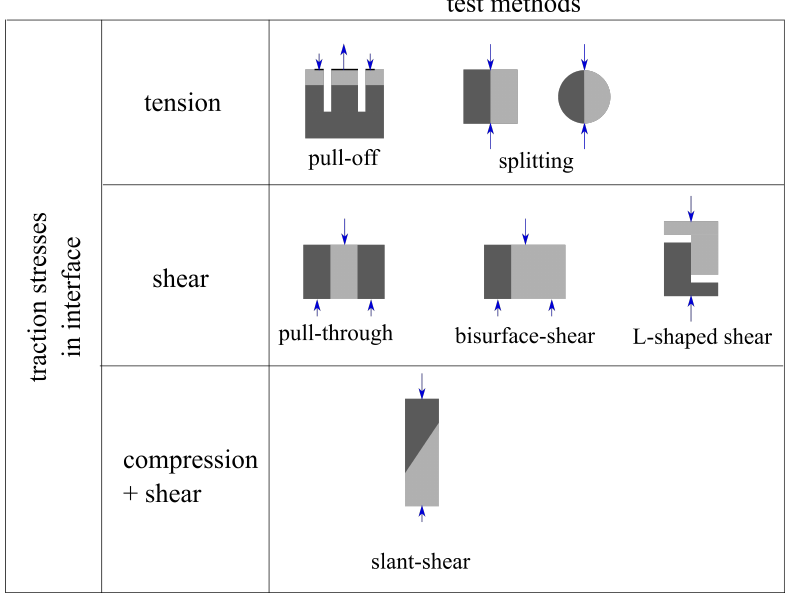
Figure 2. The most popular methods of testing concrete-to-concrete interfaces